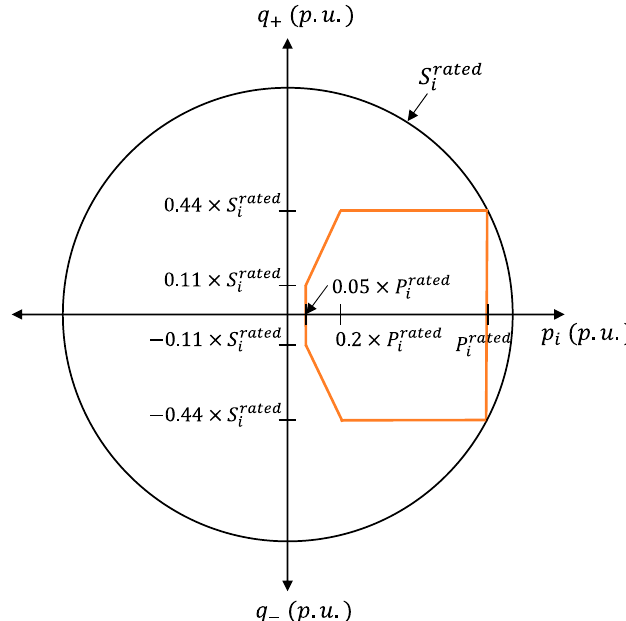
Figure 3. Reactive power capability curve for each inverter.